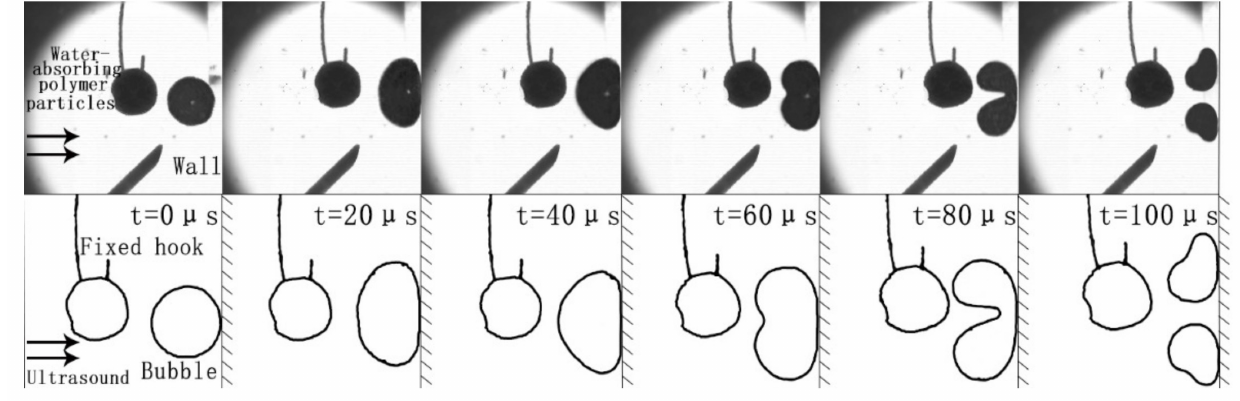
Figure 8. The impact of a single bubble collapse on surrounding particles.